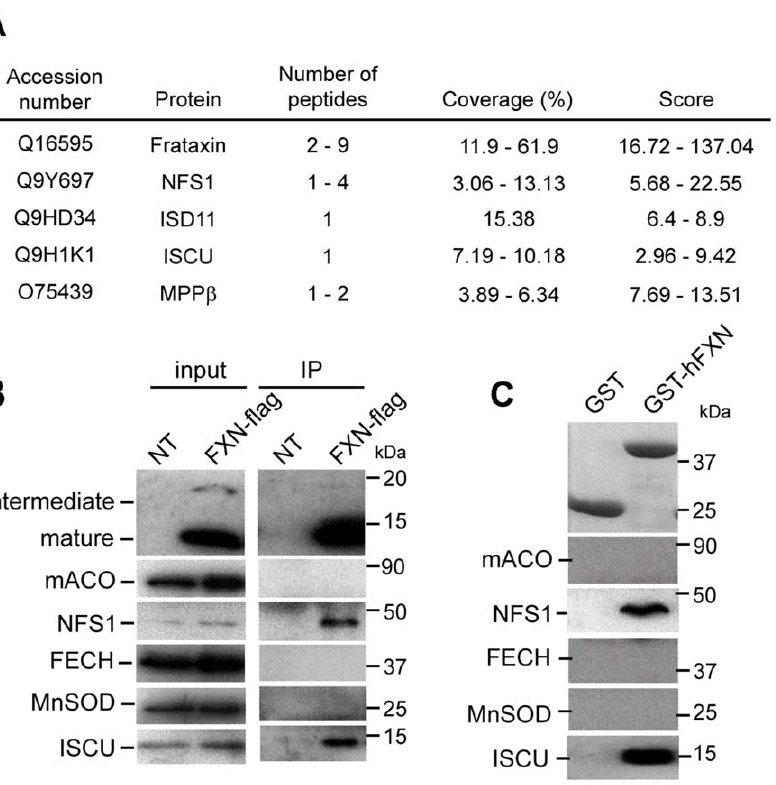
Figure 1. Human frataxin interacts specifically with ISCU, NFS1 and ISD11. (A) Mass spectrometry analysis of proteins identified by co-IP with FLAG-tagged frataxin from HeLa mitochondrial enriched fractions. Results represent the proteins specifically identified common to two independent experiments with hFXN-FLAG expressing cells compared to non-transfected cells. Peptides were selected with a stringent filter to avoid a maximum of false positives. Coverage represents the percentage of sequence matching with peptides found in the analysis. An example of complete results for one experiment is given in Table S1. (B) IP obtained in (A) were analyzed by Western blot using specific antibodies against frataxin (intermediate and mature), mitochondrial aconitase (mACO), NFS1, ferrochelatase (FECH), MnSOD and ISCU. MnSOD was used as a control to evaluate non-specific binding on the beads. Inputs correspond to 5 m g of mitochondrial HeLa extracts. (C) GST pull-down using GST-hFXN (aa 81–210) and HeLa mitochondrial extracts. Eluted fractions were analyzed by Western blot as in (B) or by coomassie blue staining to detect GST and GST-hFXN.